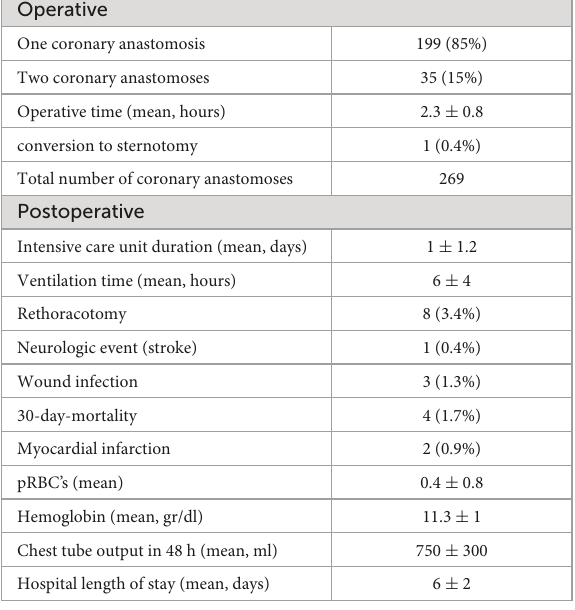
TABLE 2 Operative and postoperative